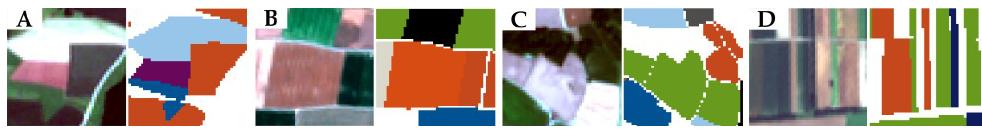
Figure 6. ( A )–( D ) Four random samples of input-output pairs from the Munich dataset. The input on the left is shown as an RGB image, while the output shows the class labels as